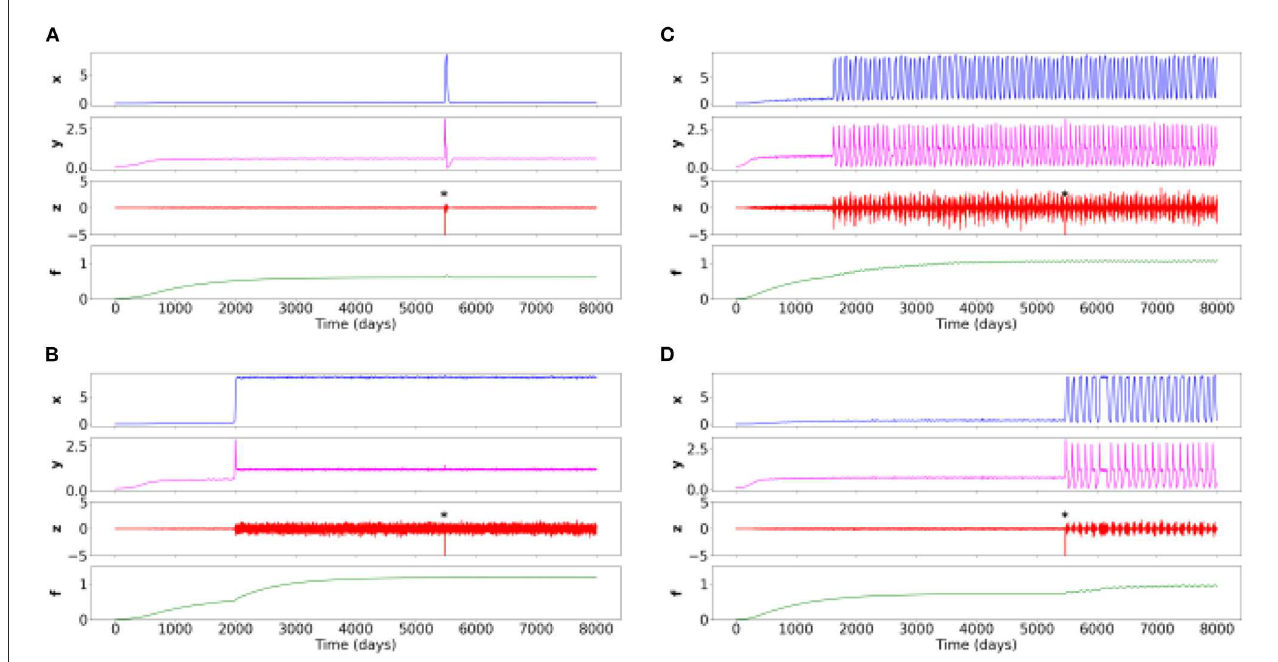
FIGURE2 Time series of the four simulations for different sets of parameters. Negative events from the environment (variable z ) are labeled with an asterisk. (A) Healthy situation: the negative event creates transient symptoms ( x ), potentiation of internal elements ( y ), and environmental sensitivity, and then returns to the baseline healthy level. (B) Constant symptom pathology (e.g., schizophrenia spectrum): symptoms appear at some point in life when potentiation has increased due to slowly changing accumulation variable f . The pathology is strongly expressed when the negative event occurs, and weakly affects the other variables. (C) Oscillating symptom pathology (rapid cycling in bipolar disorder): symptoms appear at some point in life when potentiation has increased due to a slow changing accumulation variable f . The disorder is strongly expressed when the negative event occurs which weakly affects the other variables. (D) A disorder based on oscillating symptoms (persistent complex grief disorder): a negative event triggers and stabilizes the oscillations despite the disappearance of this event.